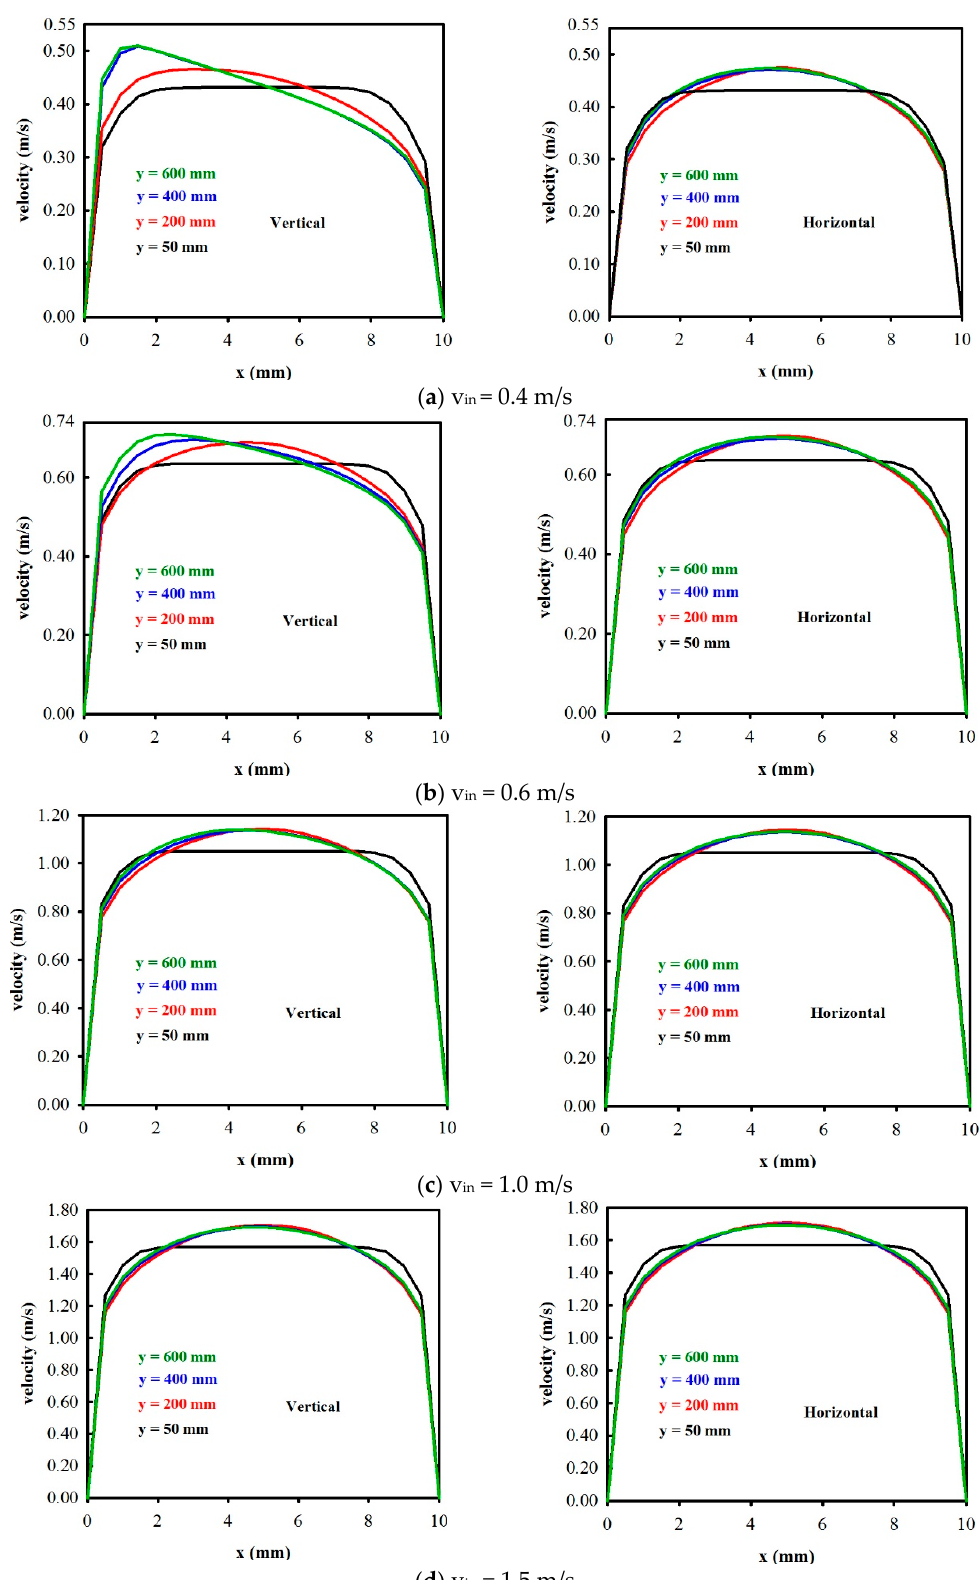
Figure 4. The velocity distributions vs. x for different v in and y for a vertical cell and a horizontal cell.